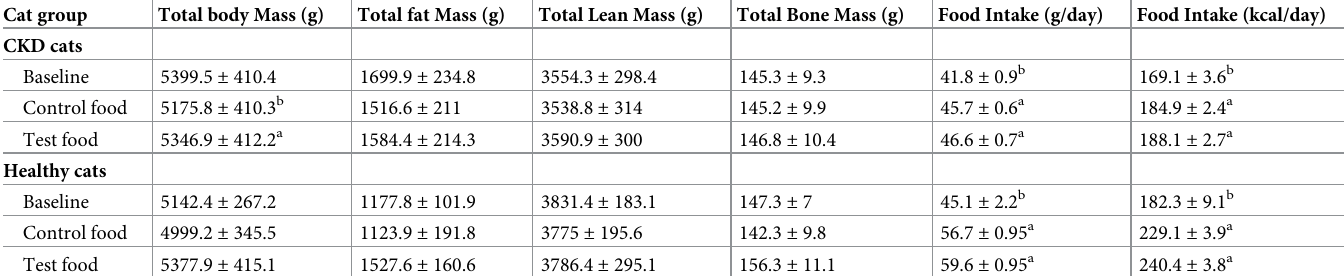
Table 2. Total body mass and food intake before (Baseline) and after feeding test and control foods for eight weeks in Chronic Kidney Disease (CKD) cats and healthy cats 1 .